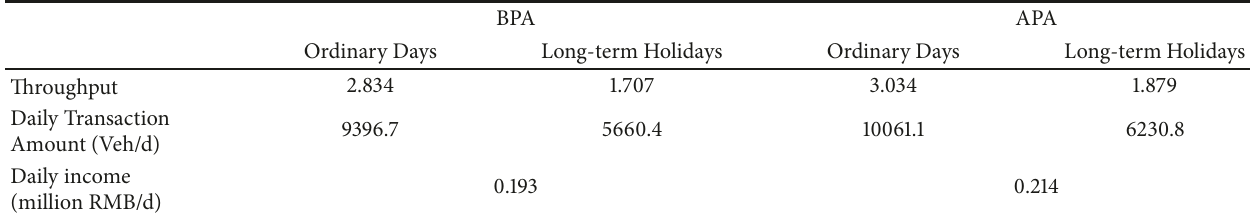
Table 5: Statistical results for profitability and facility utilization before and after price adjustment.